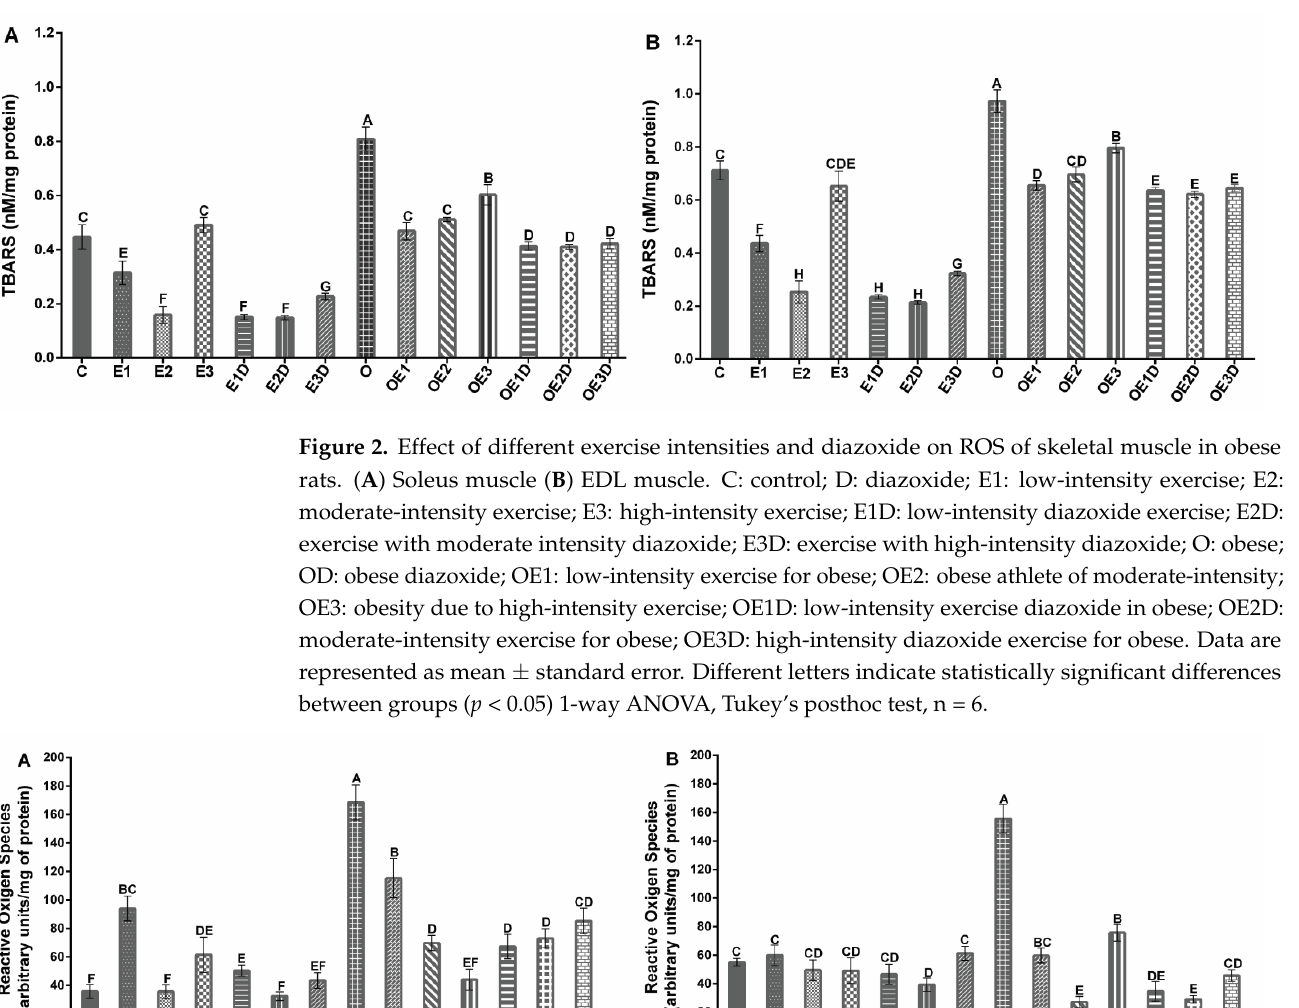
obese. Data are represented as mean ± standard error. Different letters indicate statistically signifi-